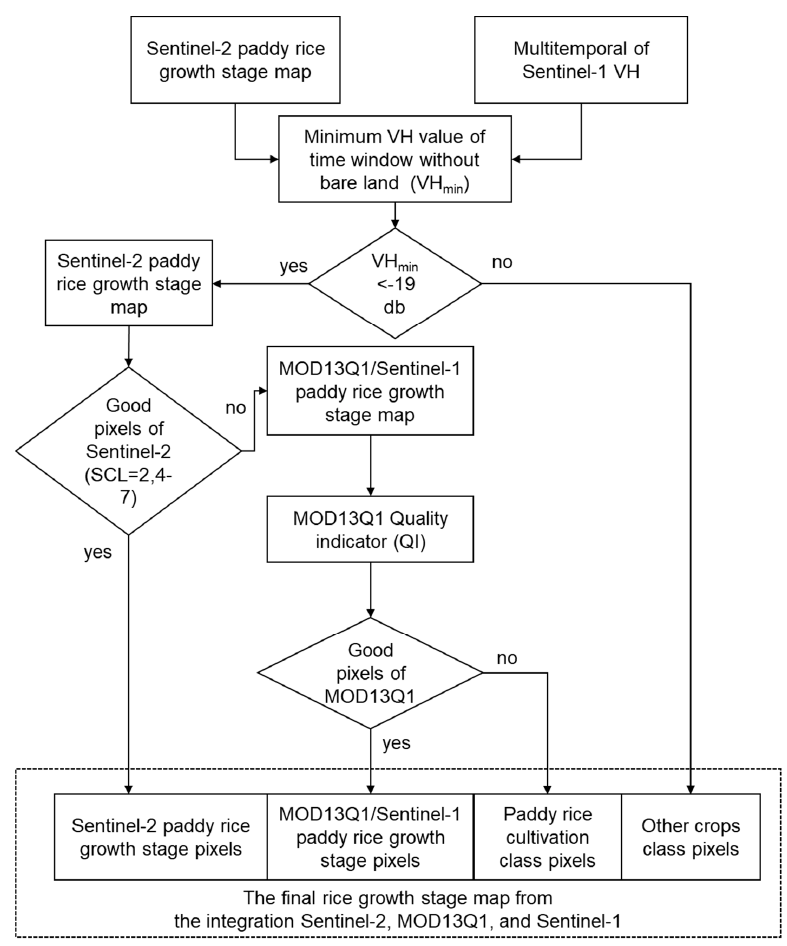
Figure 4. The flowchart of rice detection and the integration of Sentinel-2/MOD13Q1/Sentinel-1.